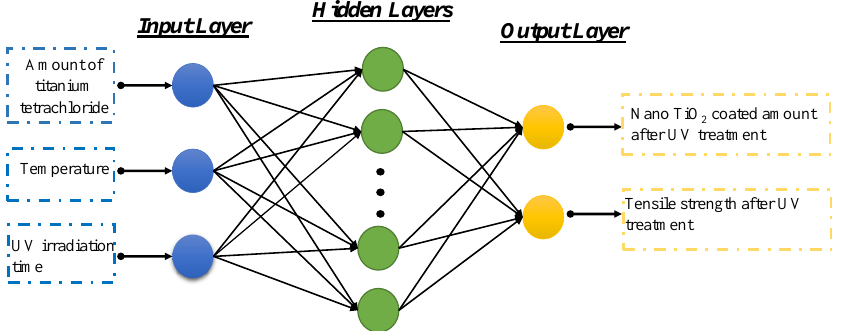
Figure 1. ANN model for the prediction of nano TiO 2 coated cotton and tensile strength of coated cotton after UV